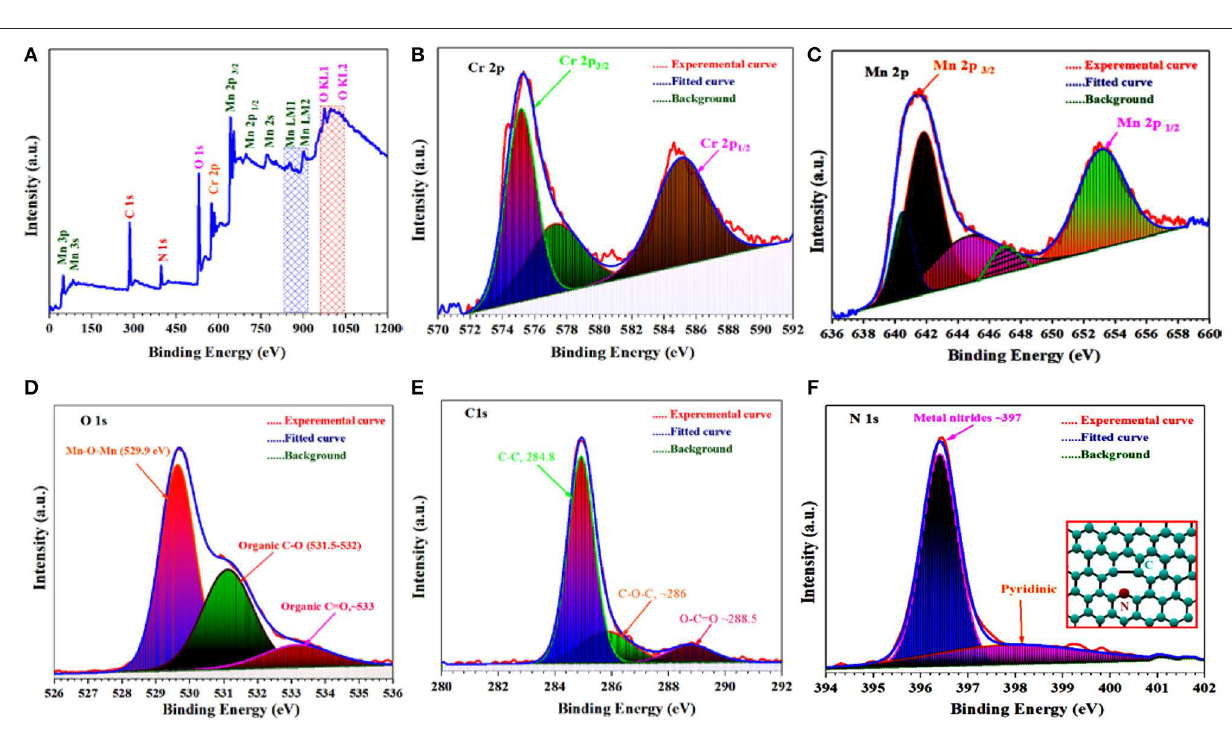
FIGURE 8 | Full wide-scan XPS data of Cr/rGO nanocomposite with MnO. (A) High resolution. (B) Cr2p. (C) Mn2p. (D) O1s. (E) C1s. (F) N1s. XPS, X-ray photoelectron spectrometry; rGO, reduced graphene